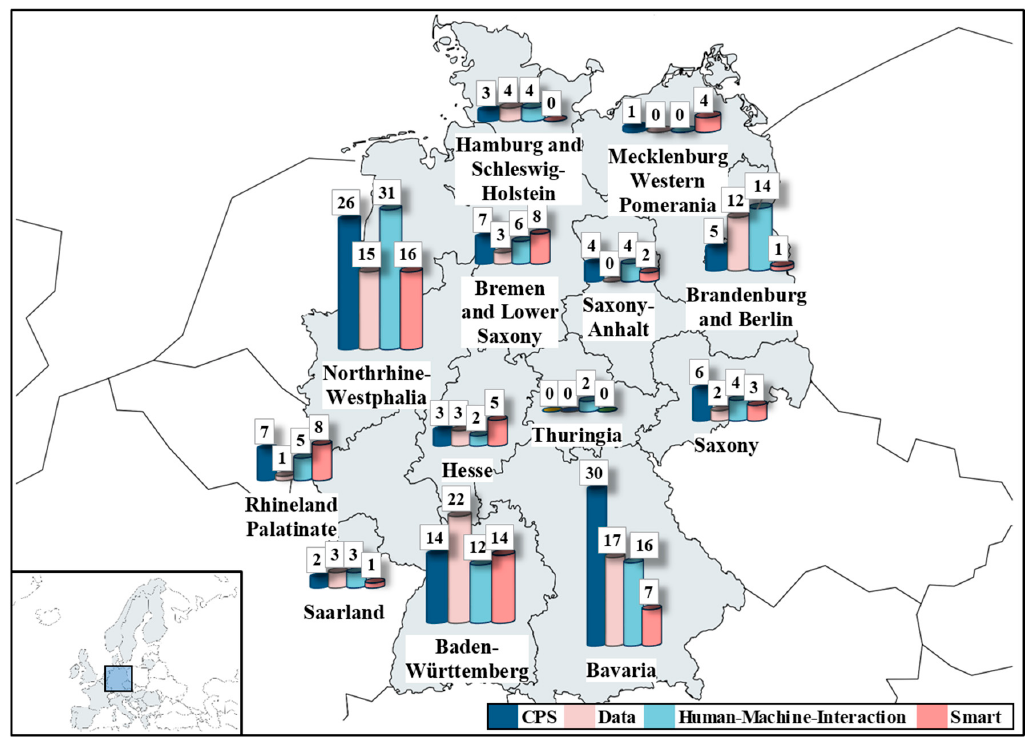
Appl. Sci. 2019 , 9 , x FOR PEER REVIEW Figure 5. Papers identified in the uncorrelated national analysis. Sources of the shapefile: [38–40]. Taking a closer look at the federal state of North Rhine-Westphalia (NRW) (Figure 6), the